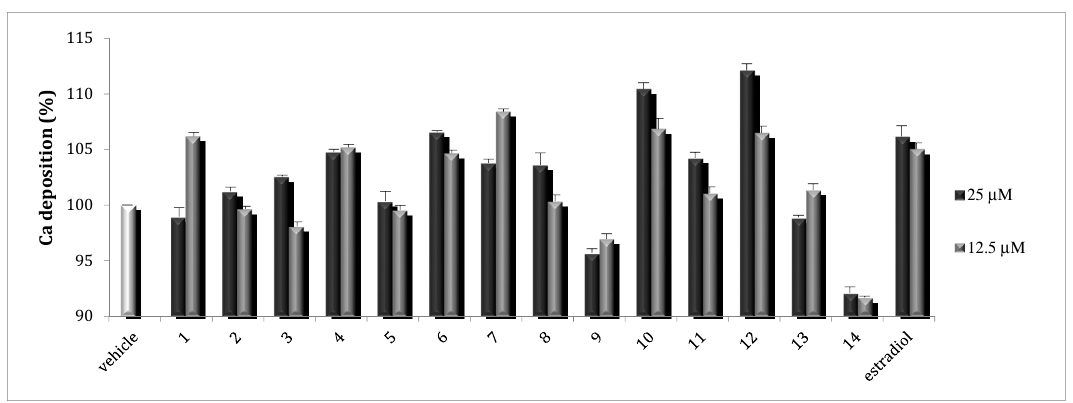
Figure 5. Calcium deposition of 1–14 toward MC3T3-E1 cell lines .